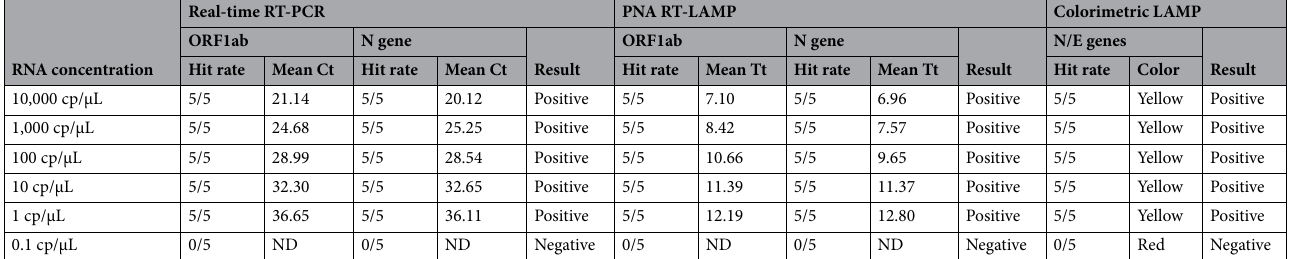
Table 4. Comparative analysis of RT-LAMP, real-time PCR and colorimetric LAMP assays. All three methods exhibited the lowest detection limits capable of detecting SARS-CoV-2 genomic RNA of 1 genomic copy (cp) per µL of RNA extract. All three assays could not detect dilution series contain 0.1 cp/µL of SARS-CoV-2 RNA.